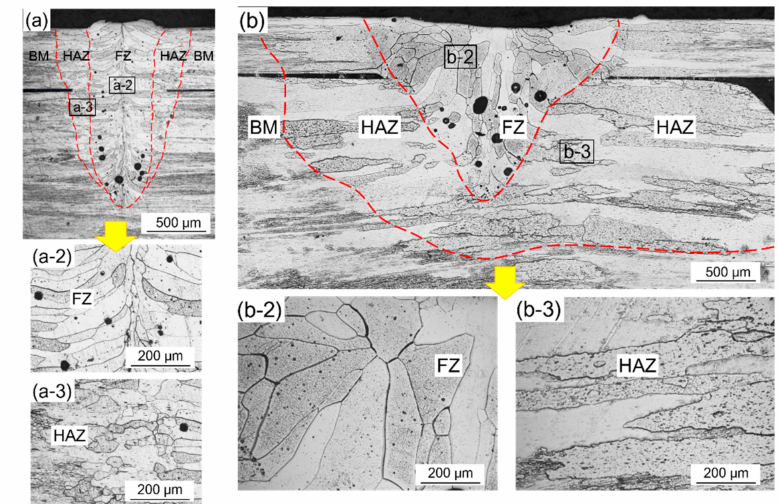
Figure 8. The cross-sectional microstructures of the NS Mo alloy laser welding joints. Heat input: ( a ) 250 J / cm; ( b ) 3600 J / cm.